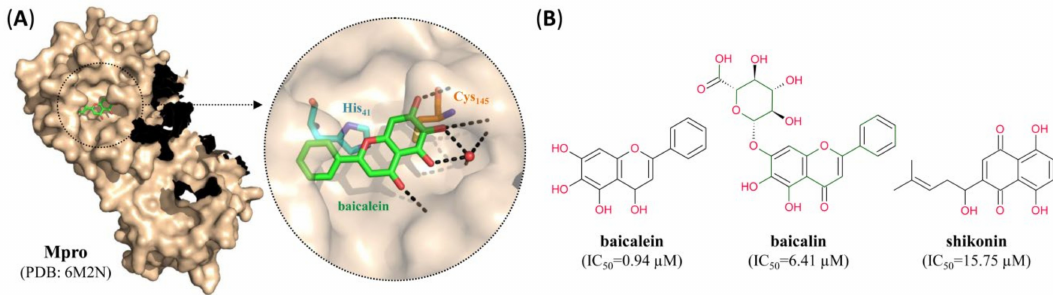
Figure 7. SARS-CoV-2 Mpro small molecule non-covalent inhibitors. ( A ) Surface representation of one protomer from the crystal structure of SARS-CoV-2 Mpro with baicalein (green) bound to the active site. Inset: close-up view of the inhibitor-bound active site, with residues forming the catalytic dyad indicated in turquoise (His 41 ) or orange (Cys 145 ) and hydrogen bonds indicated by dashed black lines. ( B ) Structure of di ff erent small molecule non-covalent SARS-CoV-2 Mpro inhibitors. For pharmacological properties, see Table 2.